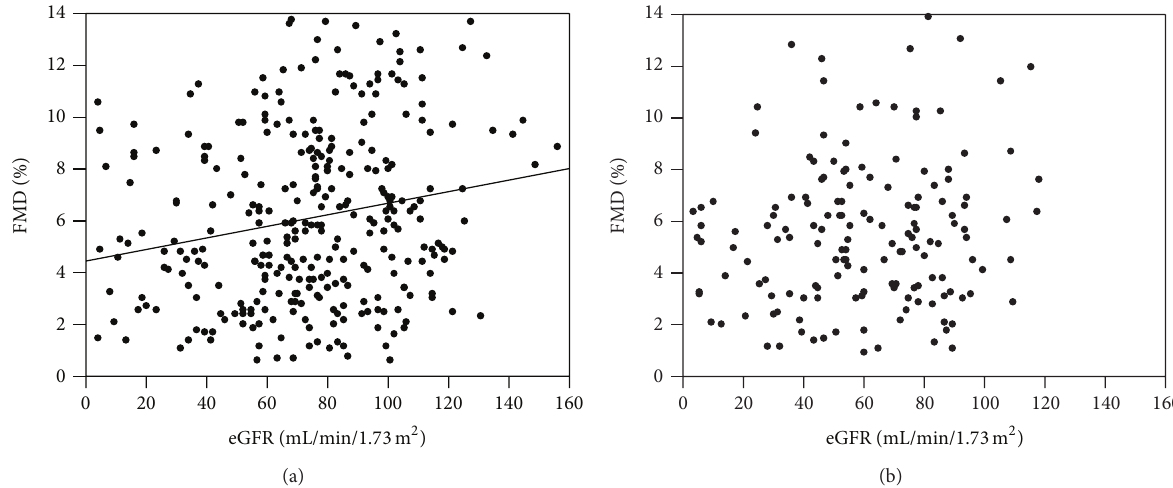
Figure 2: The relationships between the FMD and eGFR in the type 2 diabetic patients (a) without CHD ( 𝑛 = 319 , 𝑟 = 0.20 , 𝑃 < 0.01 ) and (b) with CHD ( 𝑛 = 161 , 𝑟 = 0.15 , 𝑃 = 0.06 ).